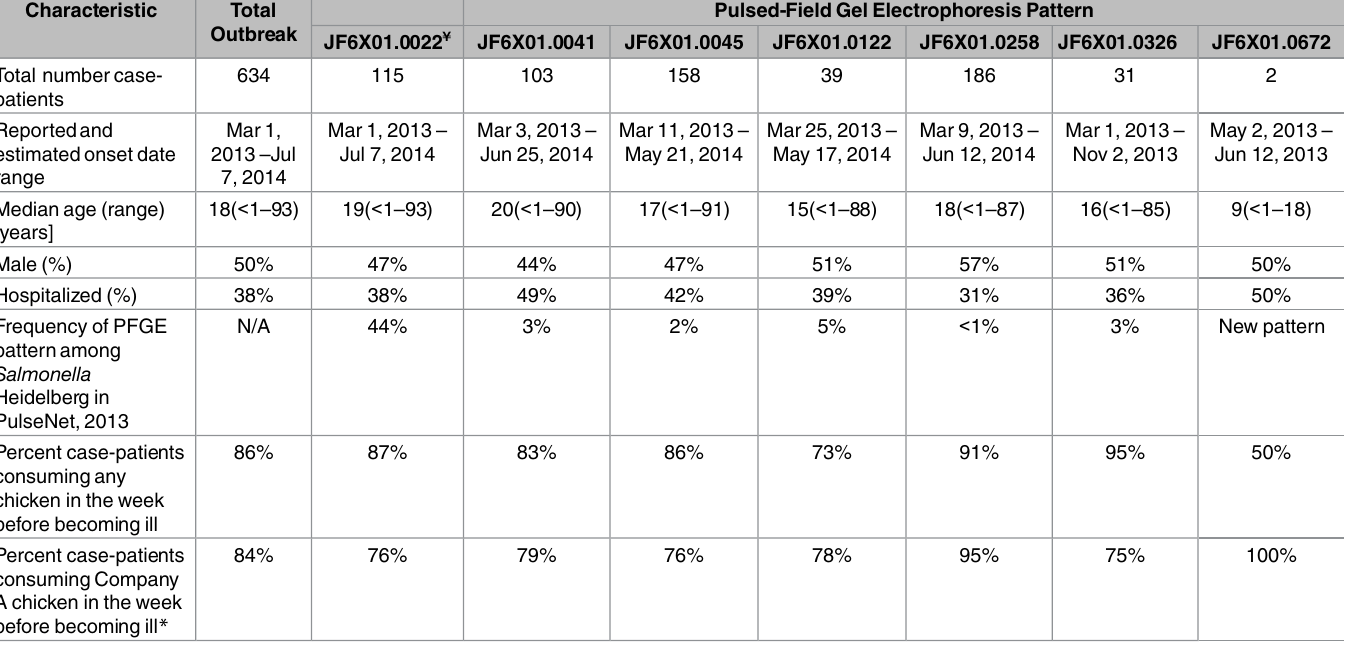
Table 1. Case-patientCharacteristicsin MultistateOutbreak of Multidrug-Resistant Salmonella HeidelbergInfections Linkedto a Single Poultry Company, by Pulsed-FieldGel Electrophoresis Pattern, 2013–2014.